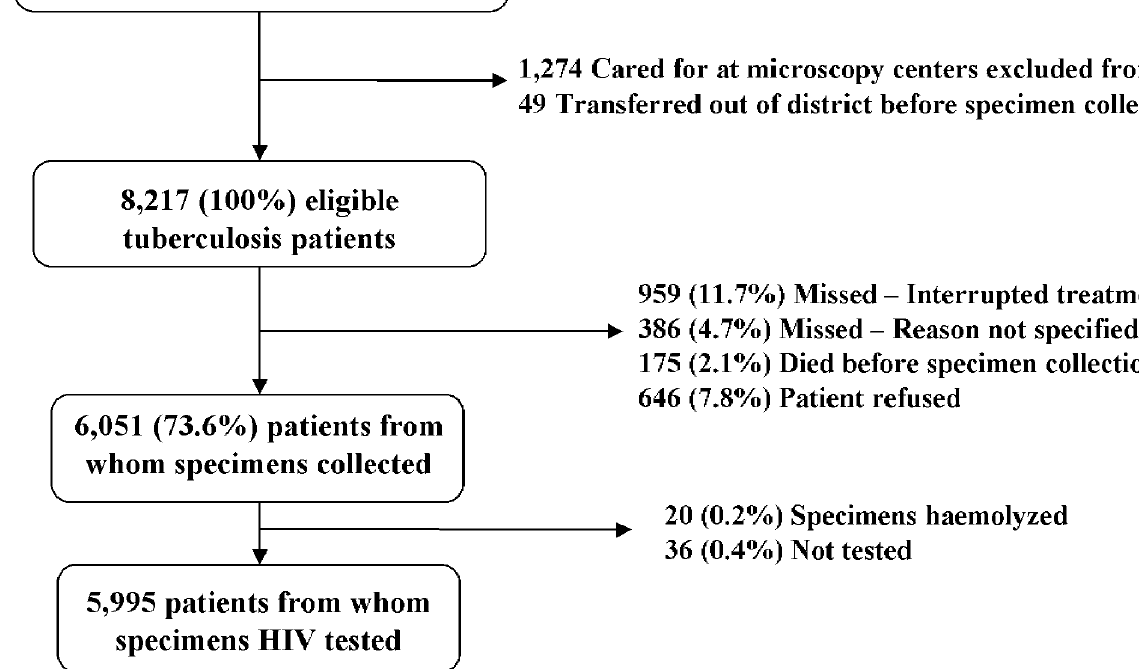
Figure 2. Survey enrollment and inclusion, with reasons for non-eligibility and non-enrollment into survey.